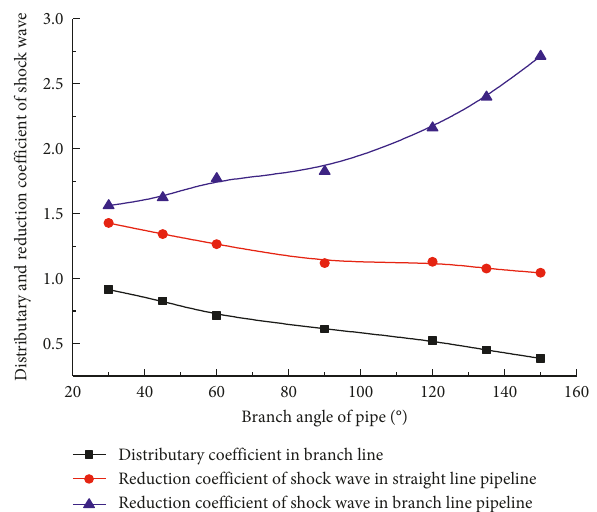
Figure 3: Shock wave attenuation coefficient and bifurcation coefficient change of gas explosion under pipeline one-way bi- furcation